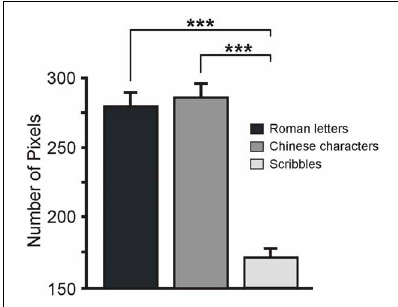
FIGURE 1 | Mean number of pixels in the three categories of stimuli. The scribbles had a number of pixels significantly inferior to symbols. Error bars represent S.E.M. ∗∗∗ p < 0 .